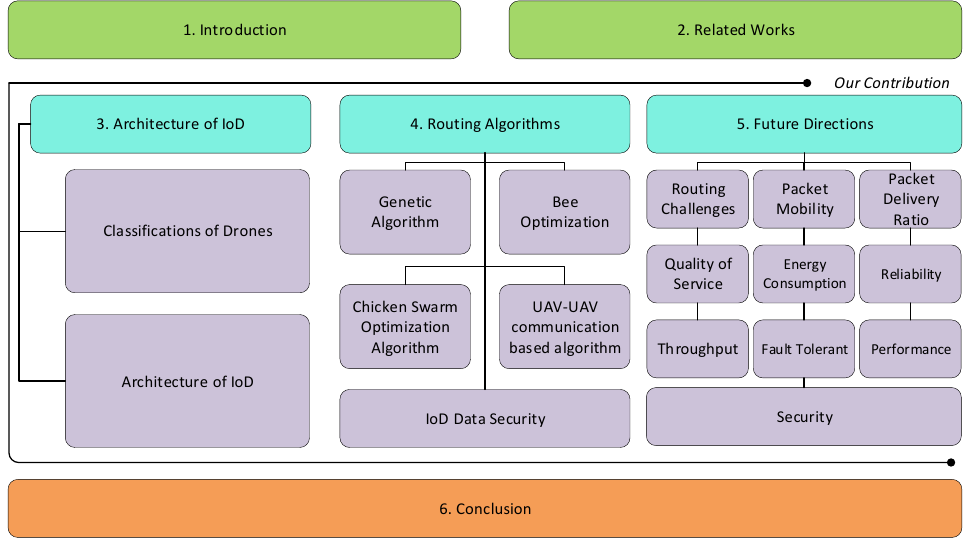
Figure 2. Structure of the